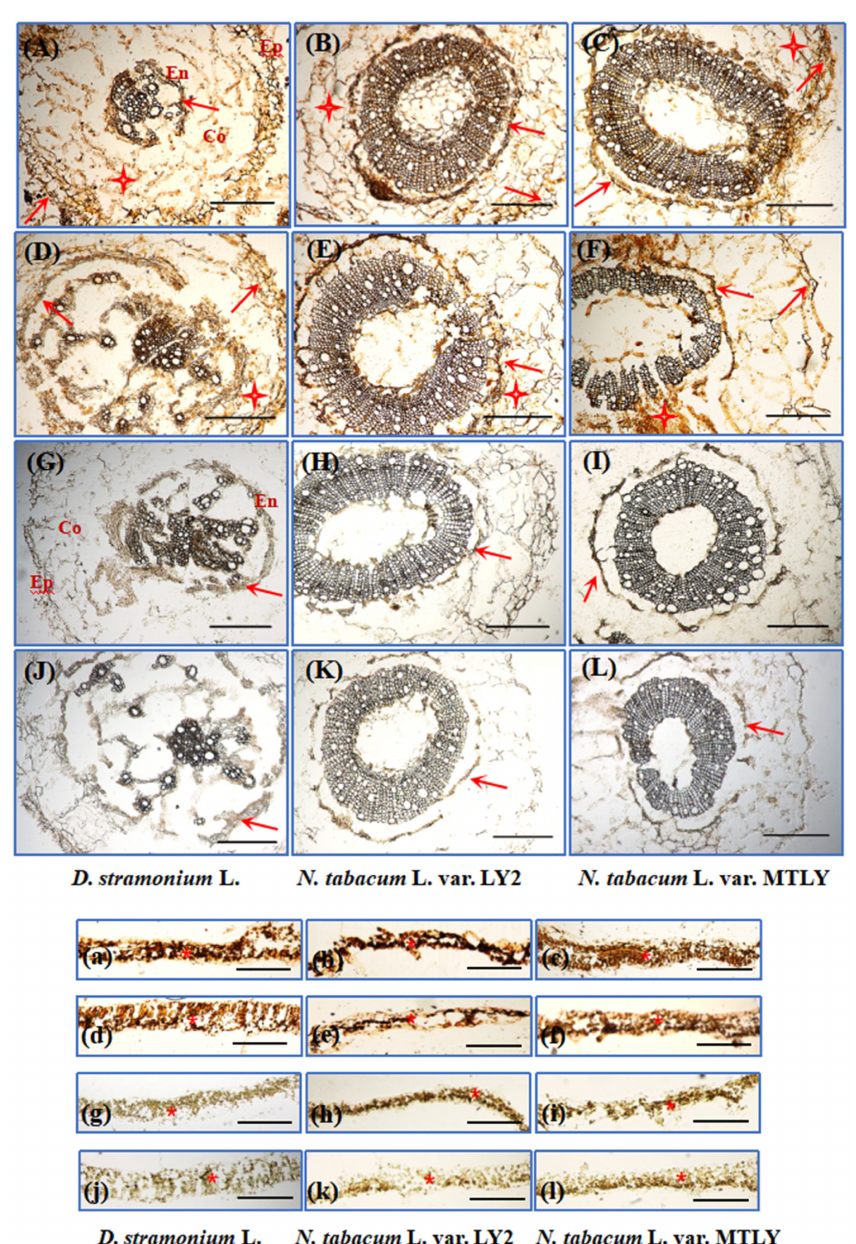
Figure 7. The production and accumulation of secondary metabolites under Cd stress. Representative photomicrographs of cross-sections via histochemical staining. Phenolic compounds were stained reddish-brown with Fast Blue BB Salt. Alkaloids stained saffron yellow with Dragendorff reagent. Phenolic compounds in roots under control conditions, ( A ) D. stramonium , ( B ) N. tabacum L. var. LY2 and ( C ) N. tabacum L. var. MTLY. Phenolic compounds in roots under Cd stress, ( D ) D. stramonium , ( E ) N. tabacum L. var. LY2 and ( F ) N. tabacum L. var. MTLY. Alkaloids in roots under control conditions, ( G ) D. stramonium , ( H ) N. tabacum L. var. LY2 and ( I ) N. tabacum L. var. MTLY. Alkaloids in roots under Cd stress, ( J ) D. stramonium , ( K ) N. tabacum L. var. LY2 and ( L ) N. tabacum L. var. MTLY. Phenolic compounds in leaves under control conditions, ( a ) D. stramonium ,